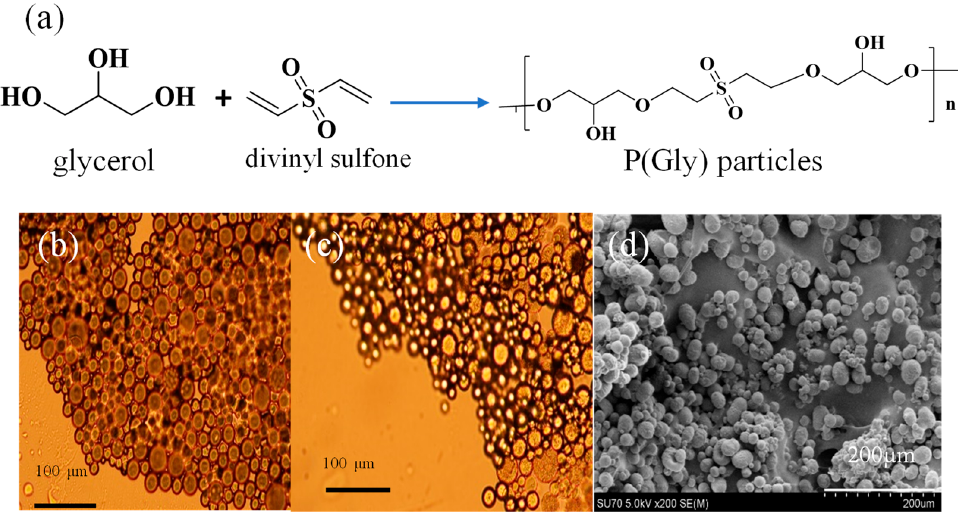
Figure 1. ( a ) The schematic presentation of p(Gly) particle preparation and the microscope image of ( b ) p(Gly) particle, ( c ) water swollen p(Gly) particles, and ( d ) SEM image of p(Gly) particles.